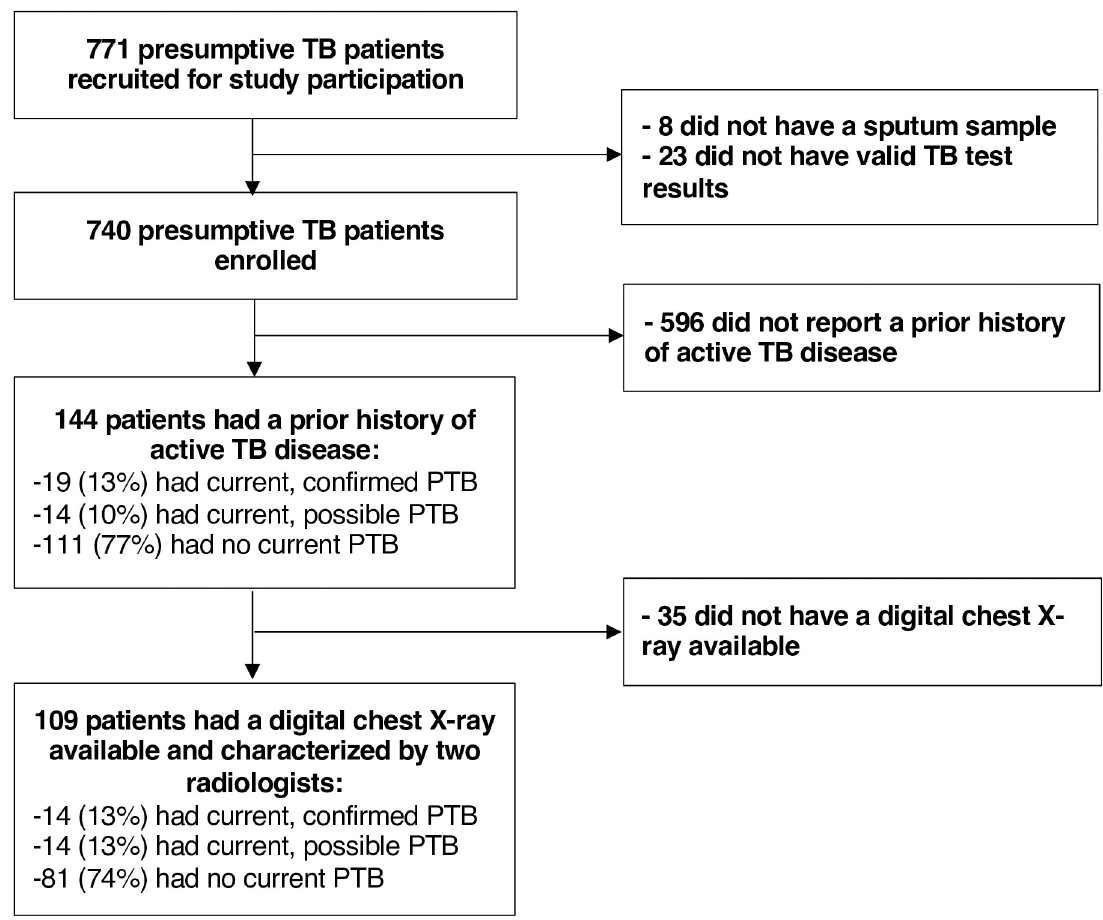
Fig 1. Study flow